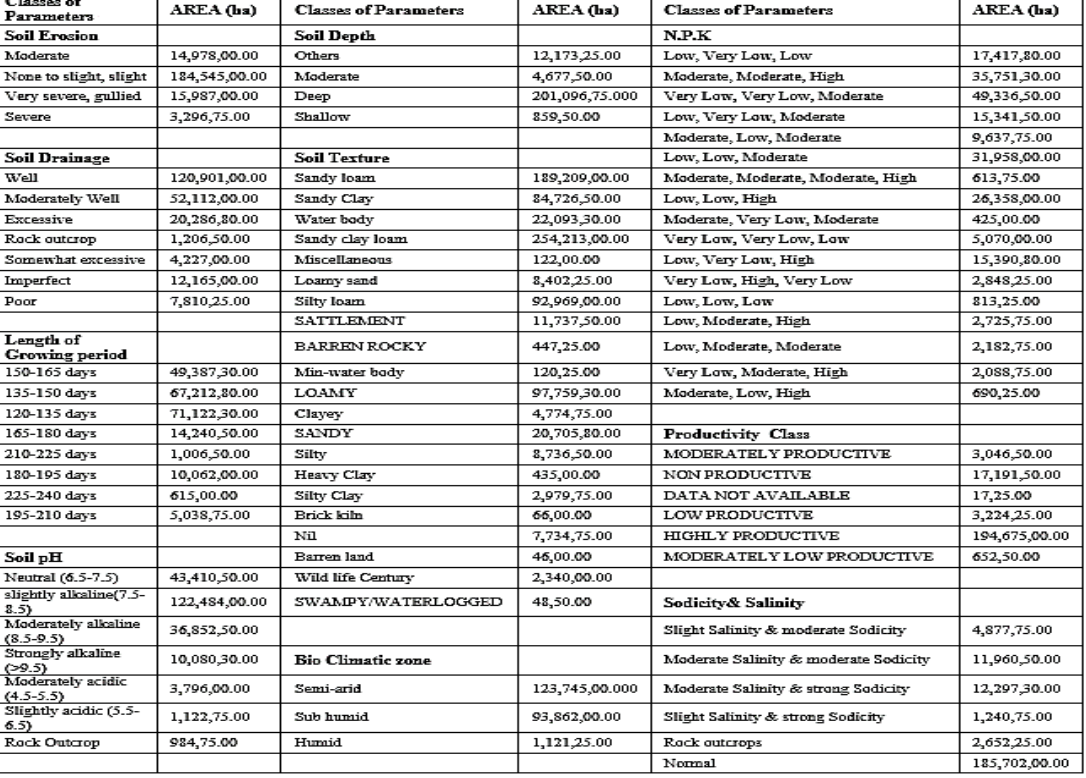
Table 2. Area of parameters classes